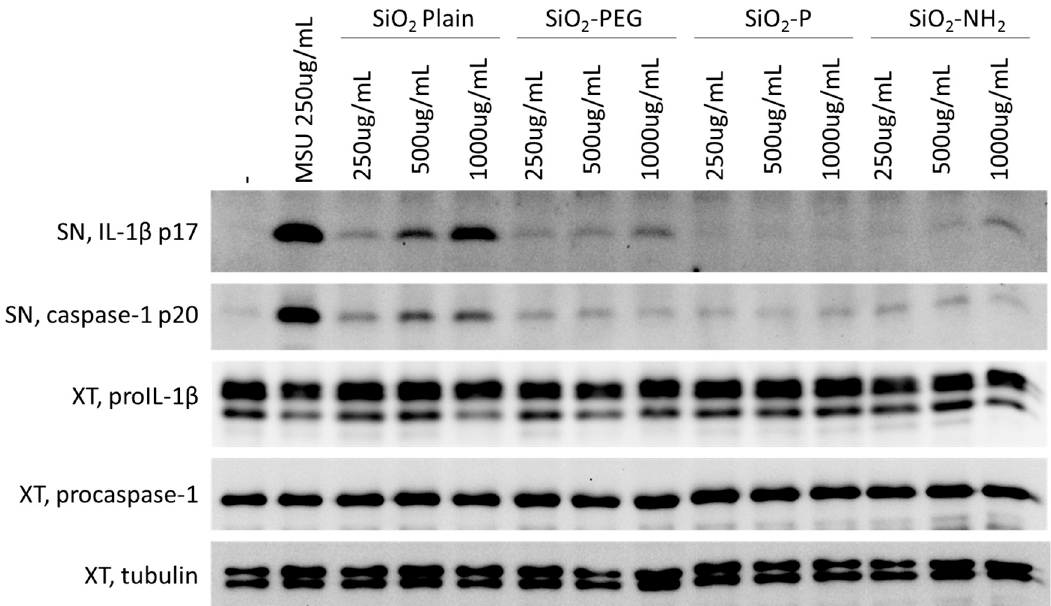
Figure 1. Surface modifications of silica nanoparticles diminish IL-1 β release. Western blotting for IL-1 β active form (p17) or pro-form (pro IL-1 β ) in supernatants (SN) or cellular extracts (XT) and cleaved caspase-1 (p20) in supernatant or pro-form in XT (pro-caspase-1) in LPS-primed murine BMDC treated with increasing concentration (250–1000 µg/mL) of plain SiO 2 , SiO 2 -PEG, SiO 2 -P or SiO 2 -NH 2. Monosodium urate (MSU) crystals were used as positive control and tubulin as housekeeping gene for loading control in XT.